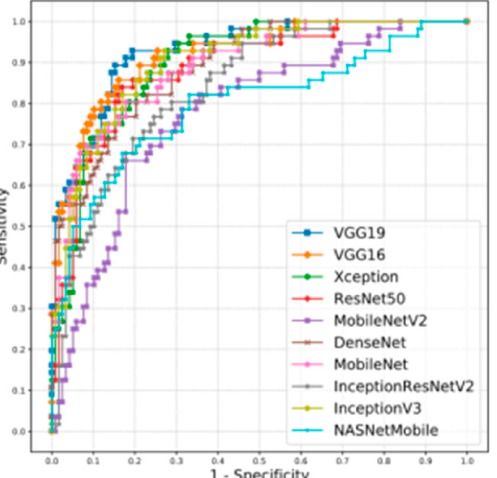
Figure 6. ROC curves for all networks using the Madrid and Zaragoza test set.